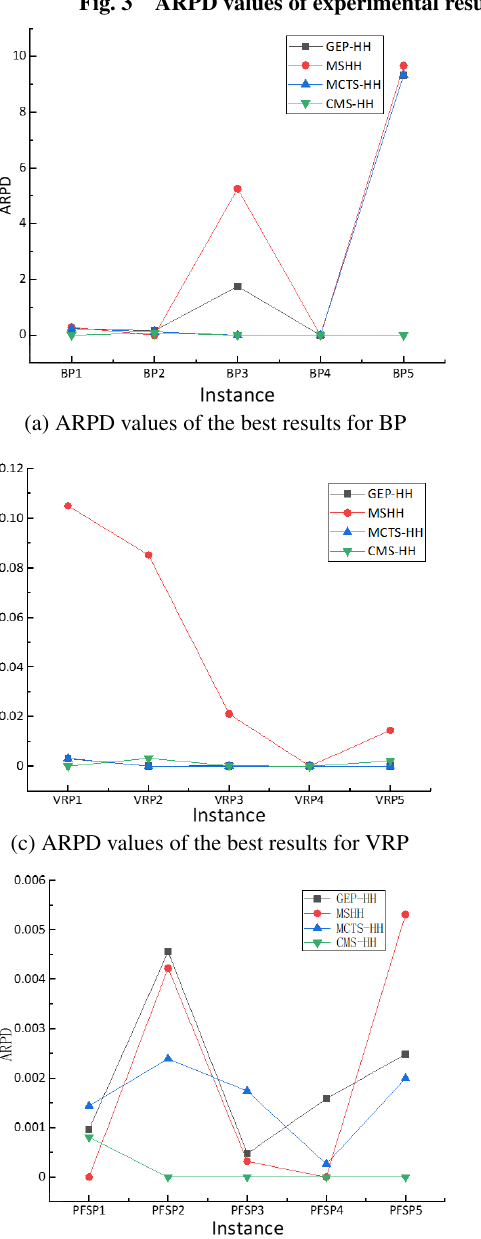
Fig. 3 ARPD values of experimental results of CMS-HH and top-five hyper-heuristics.